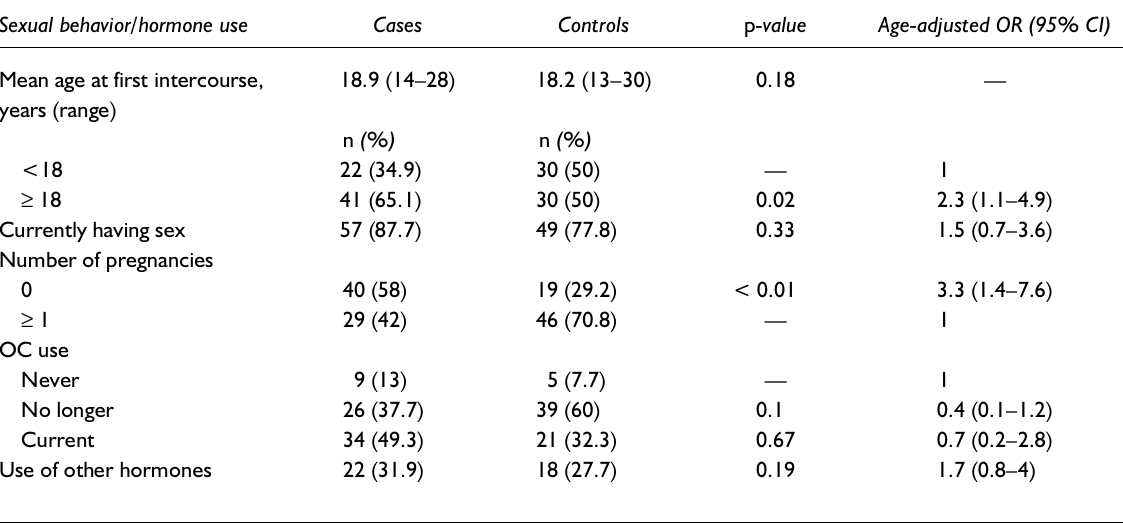
Table 2 Sexual behavior and sex steroid hormone use of VVS cases and controls